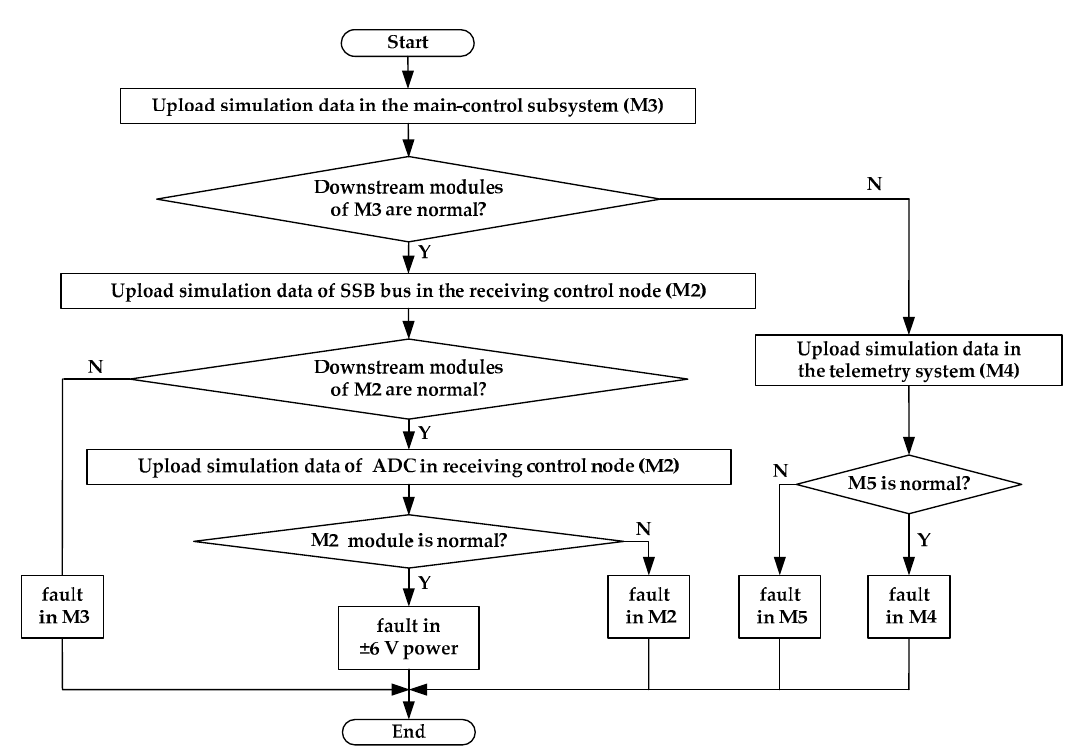
Figure 9. Flowchart of the intelligent diagnosis for global error in acquired data.